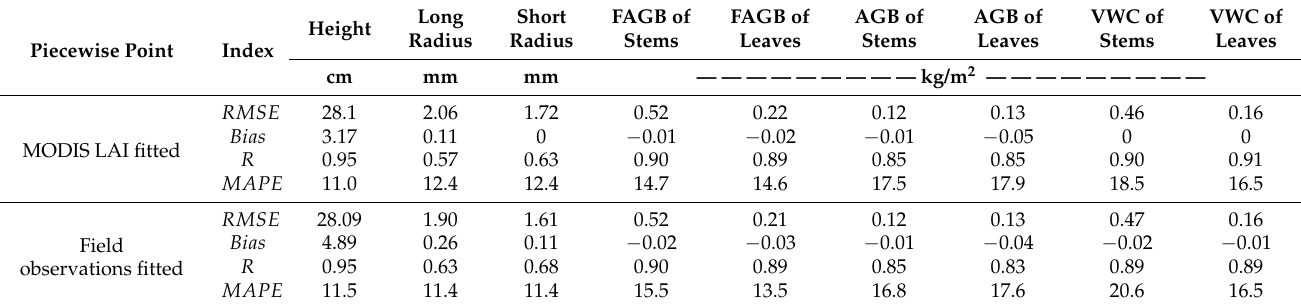
Table 6. The accuracy results of the simulated maize canopy parameters were compared to the field-measured datasets separately, based on two methods of dividing the entire growing season into two stages using the MODIS-product LAI values and the field-observed values of the extreme value